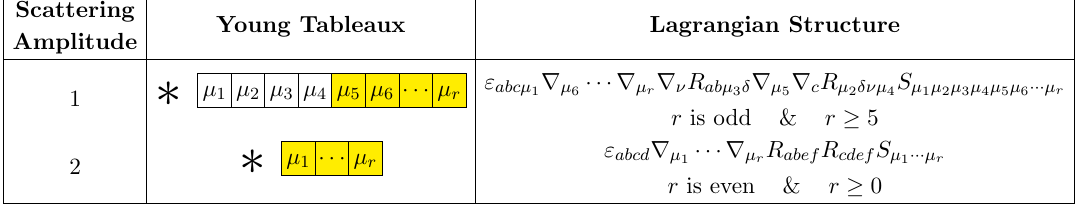
Table 10. Gravitons , D = 4. The meaning of the symbol table